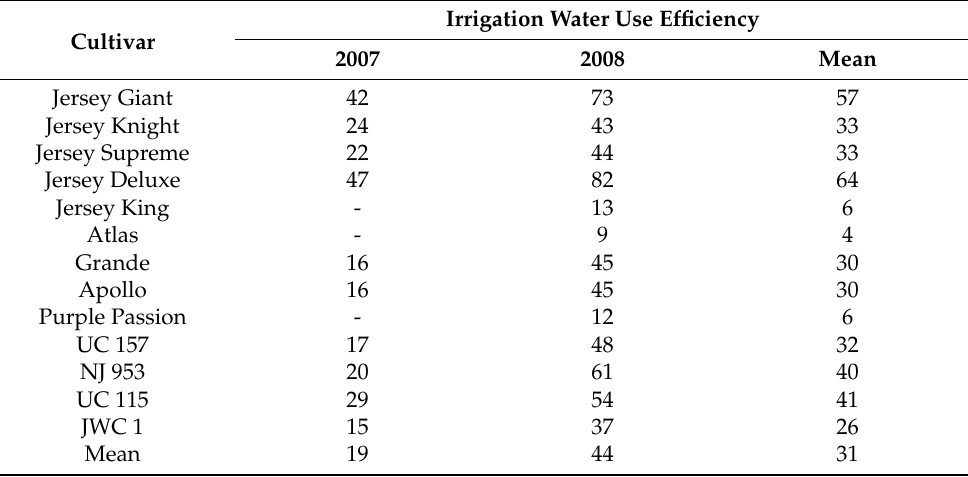
Table 13. Irrigation water use efficiency (kg · ha − 1 · mm − 1 ) as dependent on cultivar and year studied.